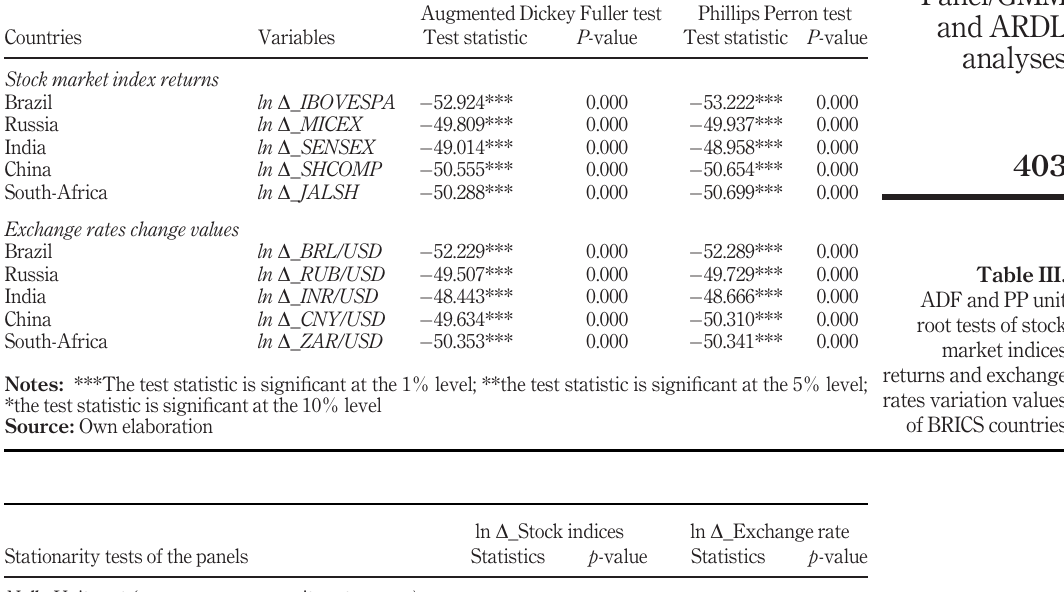
Table IV. Panel unit root